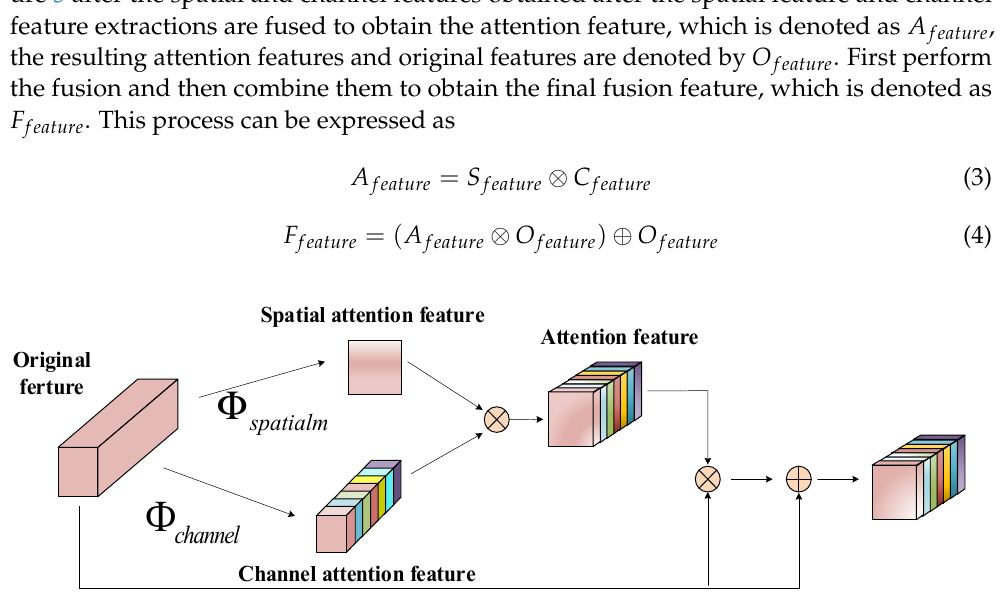
Figure 5. Structure diagram of the PAM module.